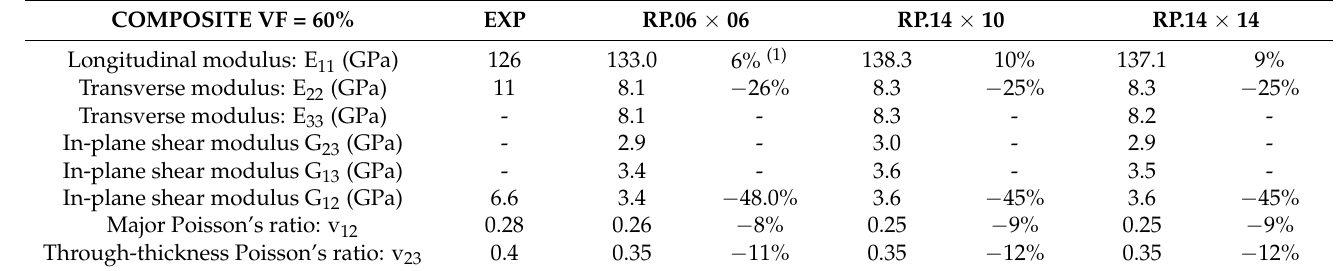
Table 7. Comparisons between the measured experimental (EXP) and the predicted effective proper- ties for RANDOM PACKAGING ARRANGEMENTS for various aspect ratios and subcell numbers.